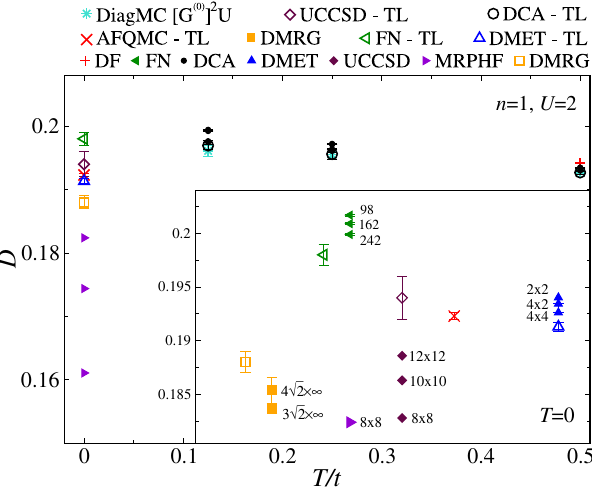
FIG. 14. Data for n ¼ 1 for U=t ¼ 2 . Main panel: Temperature dependence of double occupancy D , compiled from various techniques. Solid symbols represent finite systems; open symbols represent extrapolations to the thermodynamic limit. Finite- T results are shown for DCA (black circles) and DiagMC (turquoise asterisks), and zero- T data from DMET (blue triangles), UCCSD (maroon diamonds), MRPHF (purple triangles), DMRG (orange squares), and FN (green triangles). Inset: Zoom-in of the zero- T data from FN, UCCSD, MRPHF, DRMG, DMET, and